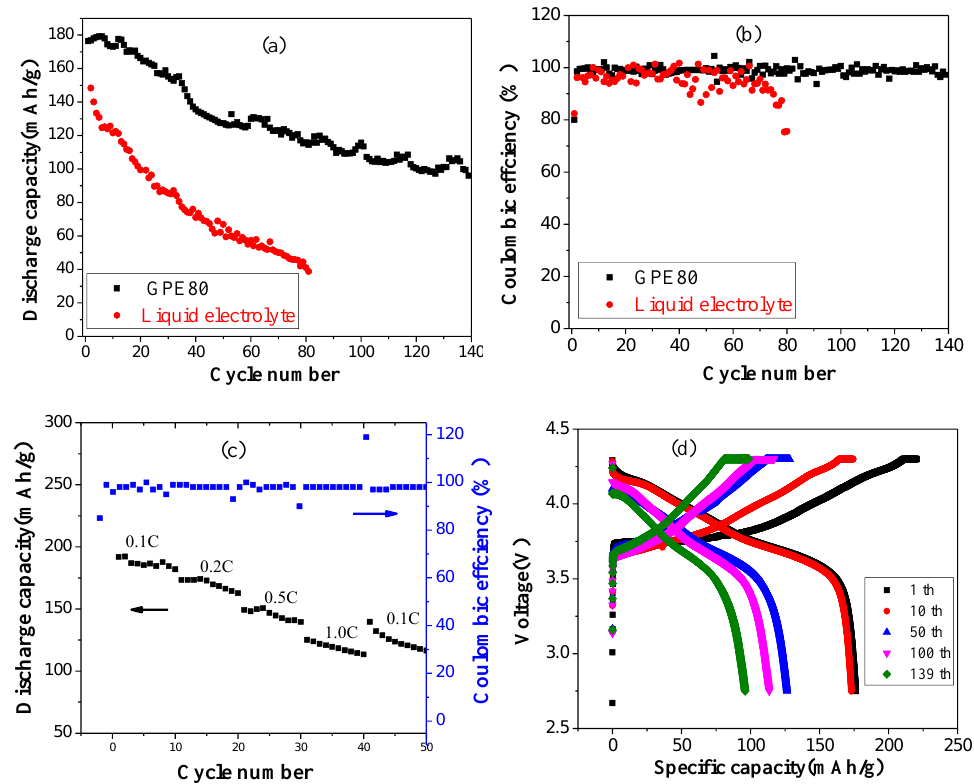
Figure 6. Characterization of lithium battery performance of GPE-80 and liquid electrolyte: ( a ) Cycle performance; ( b ) coulombic efficiency; ( c ) rate performance; and ( d ) charge and discharge profiles of GPE-80 at different cycles.